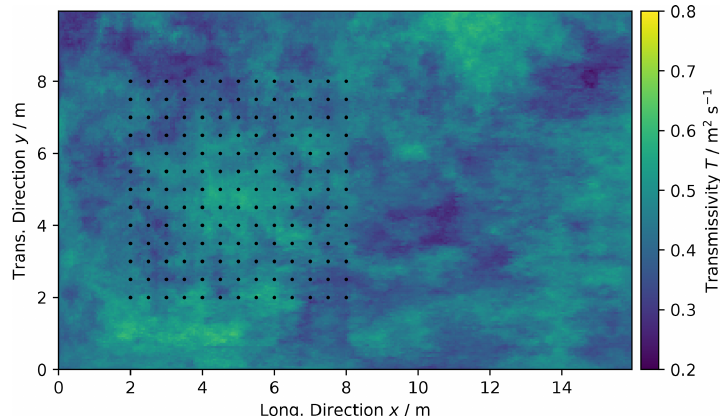
Figure 27. Transmissivity of the Herten aquifer analogue and locations of virtual observations marked as black dots.